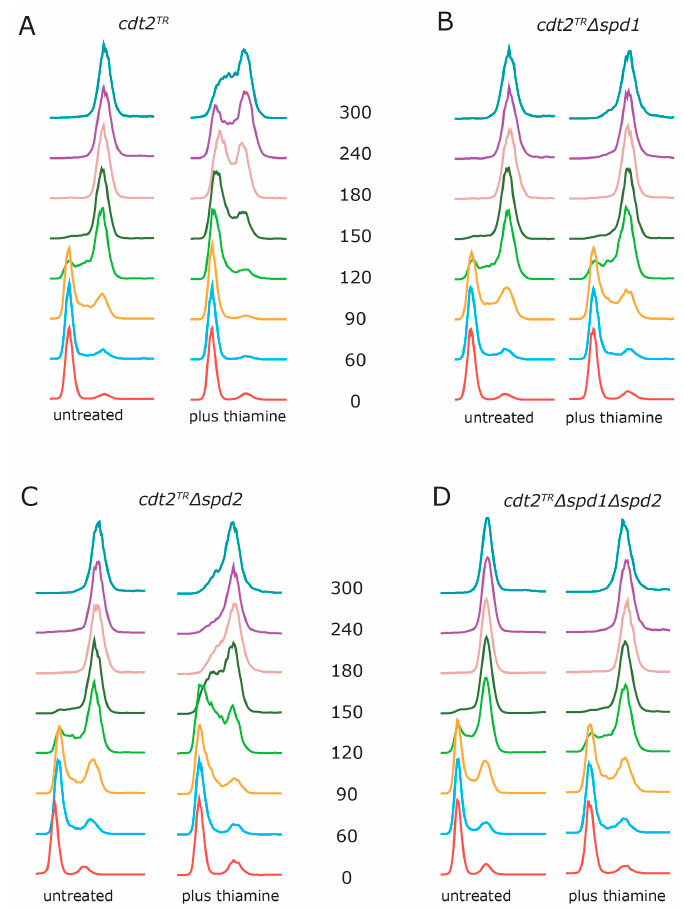
Figure 2. Spd1 accumulation inhibits S phase progression. Cells with the cdt2 TR allele were synchronized in G1 by nitrogen starvation in the presence of the M-factor pheromone [22]. The pheromone was washed away, and the cultures were released into S phase in MSL medium at 30 °C, either with or without thiamine at t = 0. Samples were taken for flow cytometry at the indicated time points (min). Genotypes: ( A ) cdt2 TR , ( B ) cdt2 TR Δ spd1 , ( C ) cdt2 TR Δ spd2 and ( D ) cdt2 TR Δ spd1 Δ spd2 .